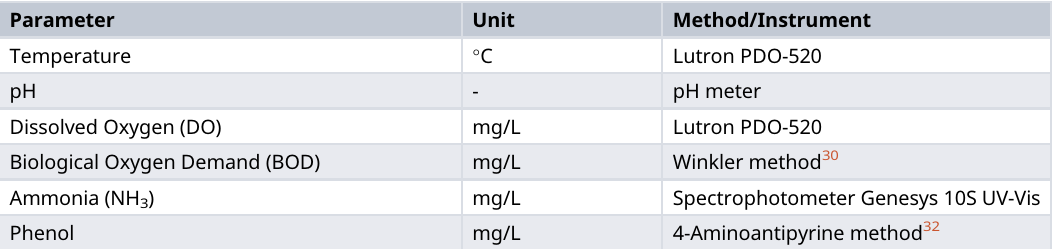
Table 1. Methods and instruments used for water quality